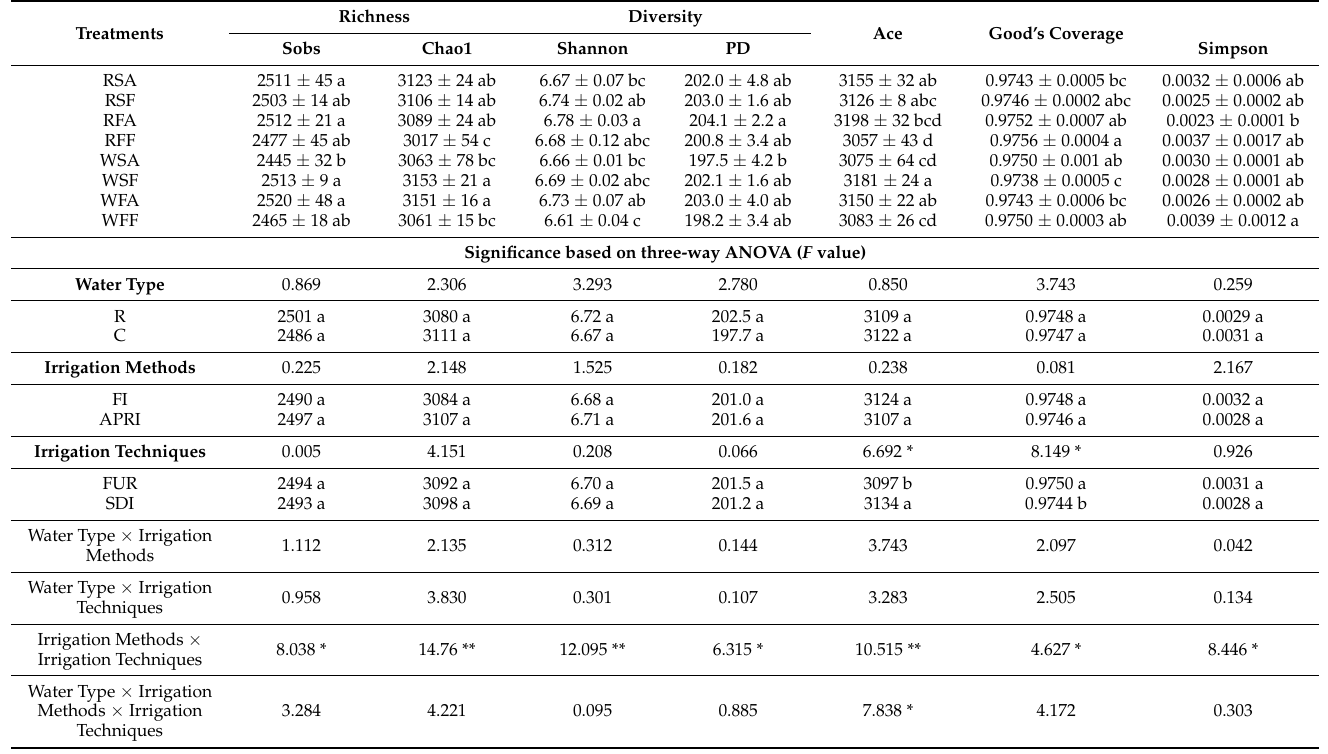
Table 5. Bacterial community diversity indices in different